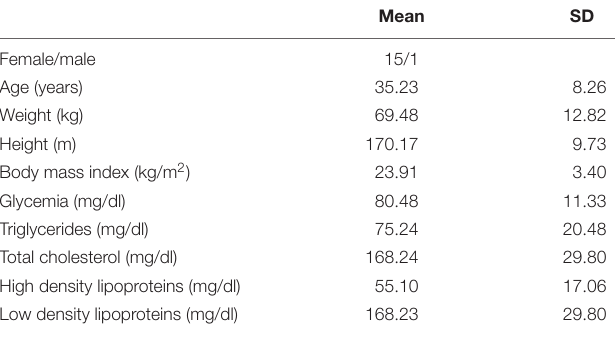
TABLE 1 | Anthropometric and biochemical data of the 30